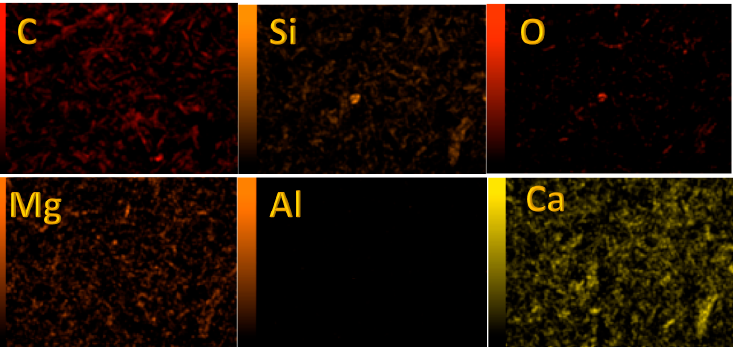
Figure 3. Elemental mapping for the produced powder after hydrothermal treatment in the presence of 1.0 M KOH at 170 °C for 3 h and calcined at 600